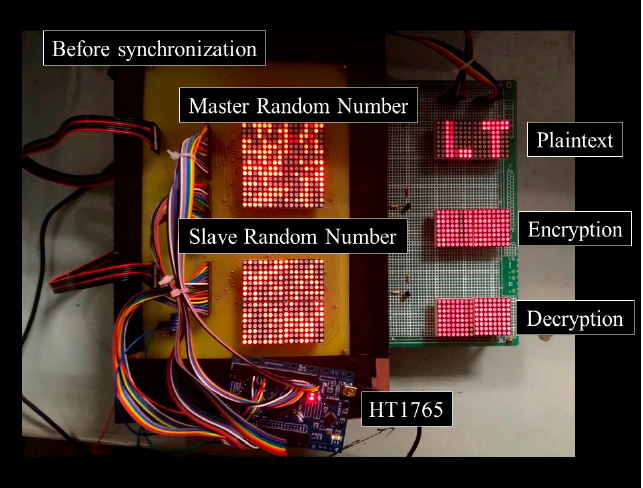
Figure 16. The secure communication system before synchronization.